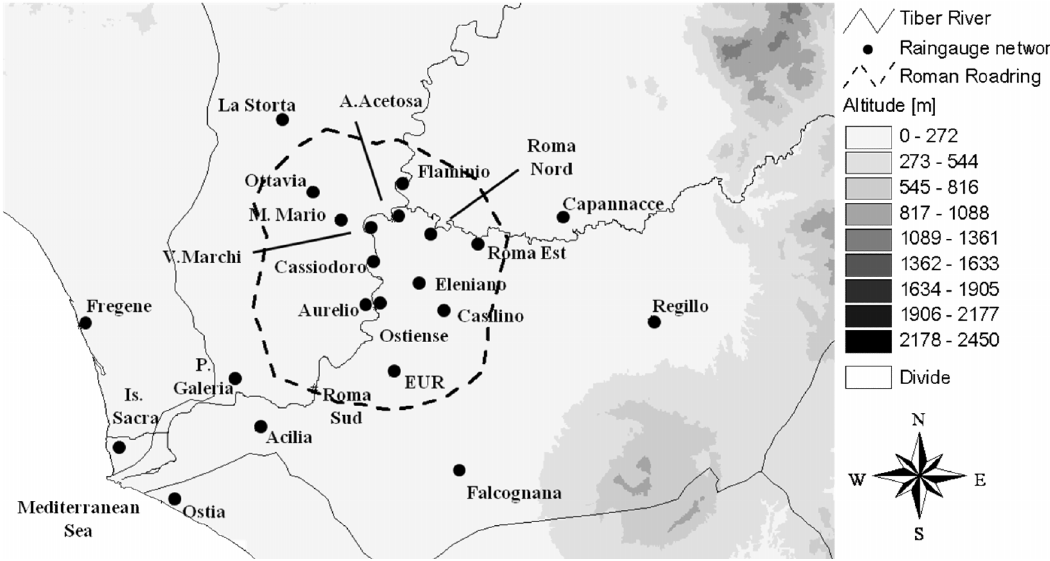
Fig. 1. Map of the rainfall network in Rome. Each raingauge is identified by